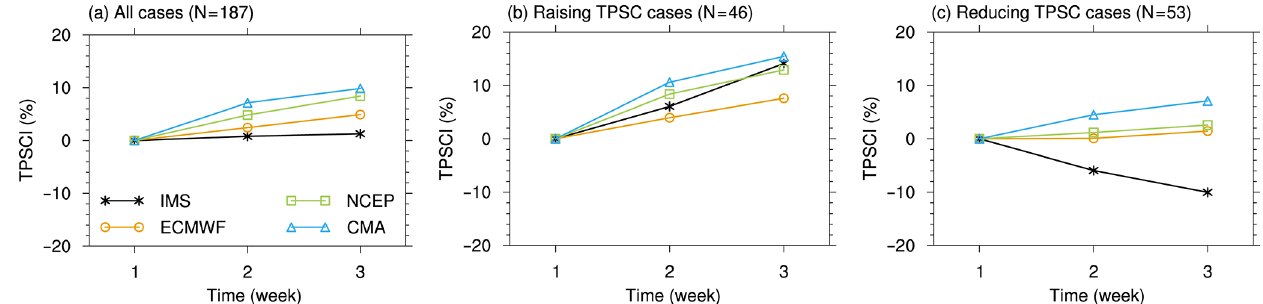
Figure 5. Composites of the Tibetan Plateau snow cover index (unit: %) for (a) all cases, (b) increasing TPSC cases and (c) decreasing TPSC cases. Black lines, orange lines, green lines and blue lines represent composites in the observation, ECMWF, NCEP and CMA, respectively; see legend in (a) . The x axis represents the number of weeks in the cases for the composites, which are also forecast lead times (unit: week). The “N” in the title of each plot indicates the number of cases for the composite.